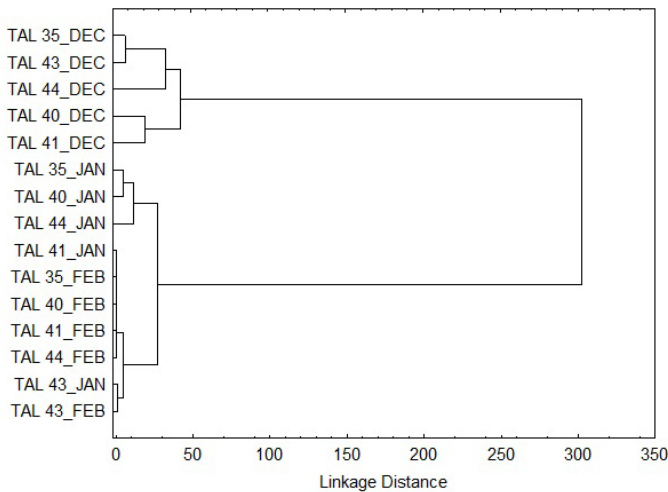
Figure 6. Dendrogram of the clustering analysis of the different fields and evaluation periods for the scores in